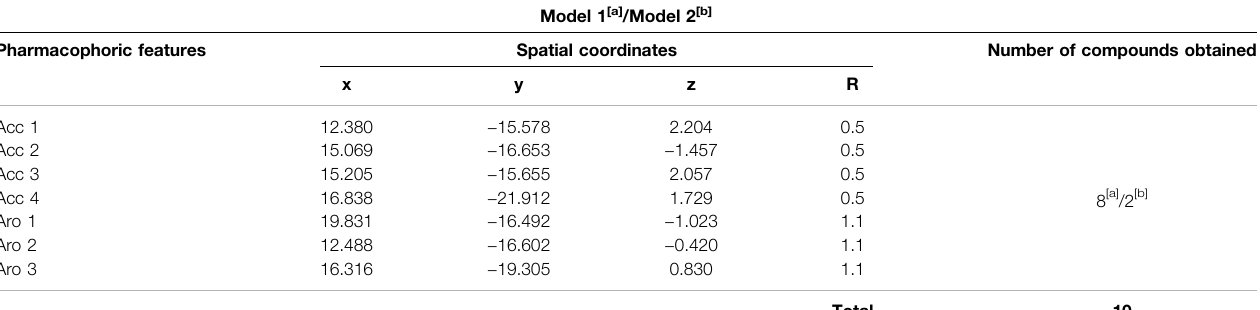
TABLE 6 | Pharmacophoric features and spatial coordinates for pharmacophore Models 1 and 2, obtained by Pharmagist and Pharmit, as well as number of compounds retrieved from corresponding virtual screening campaigns using Molport